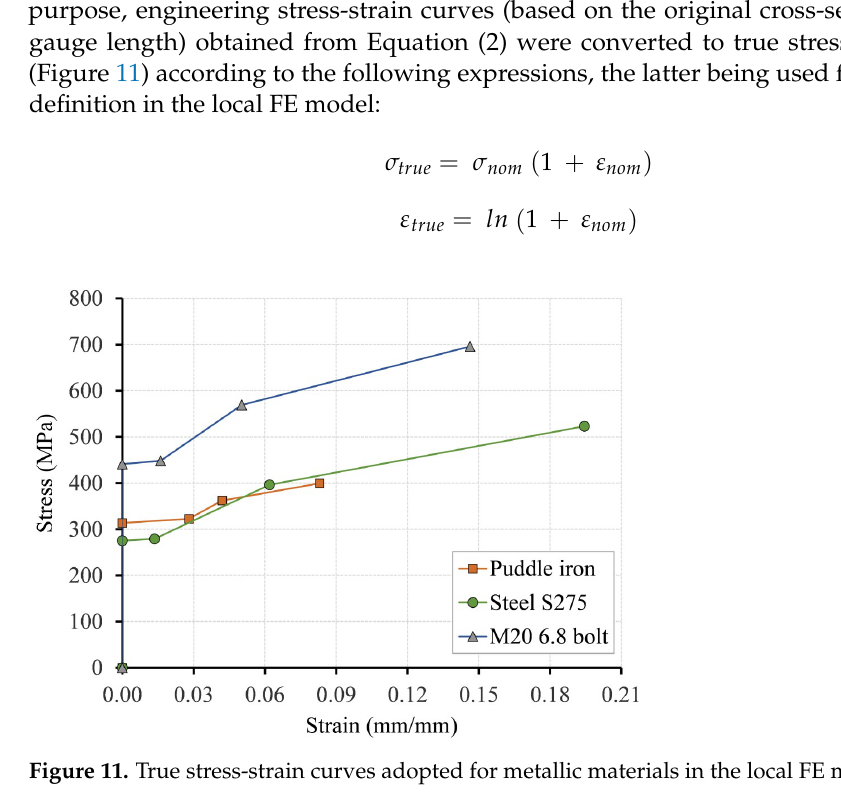
Figure 11. True stress-strain curves adopted for metallic materials in the local FE model.